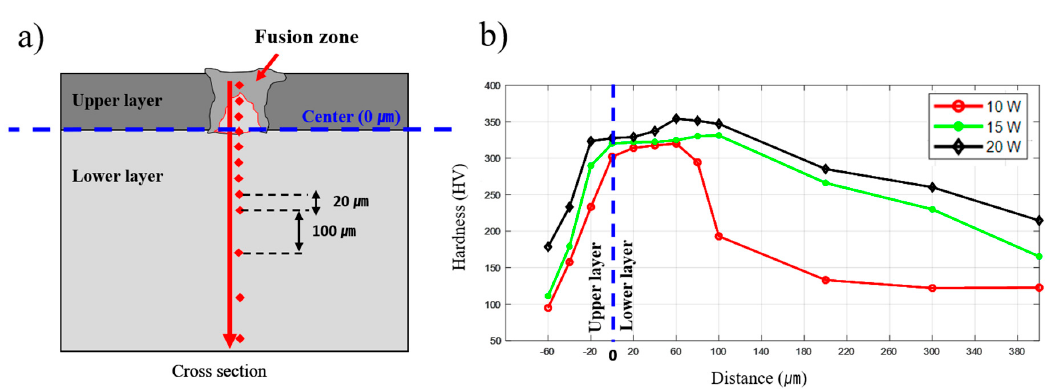
Figure 11. Hardness test on the vertical direction in the fusion zone (FZ). ( a ) Schematic illustration of the test; ( b ) hardness profile at the laser power of 10 W, 15 W and 20 W.